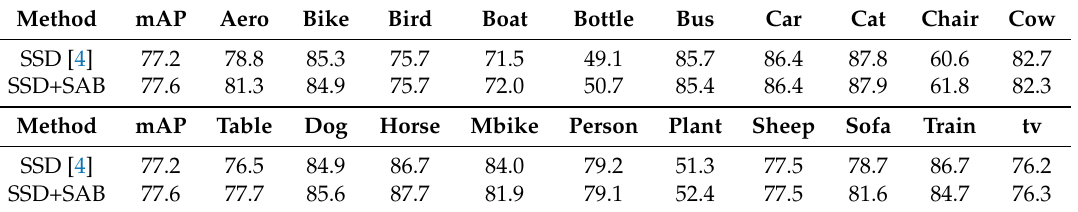
Table 2. Test results of SSD and SSD+semantic activation block